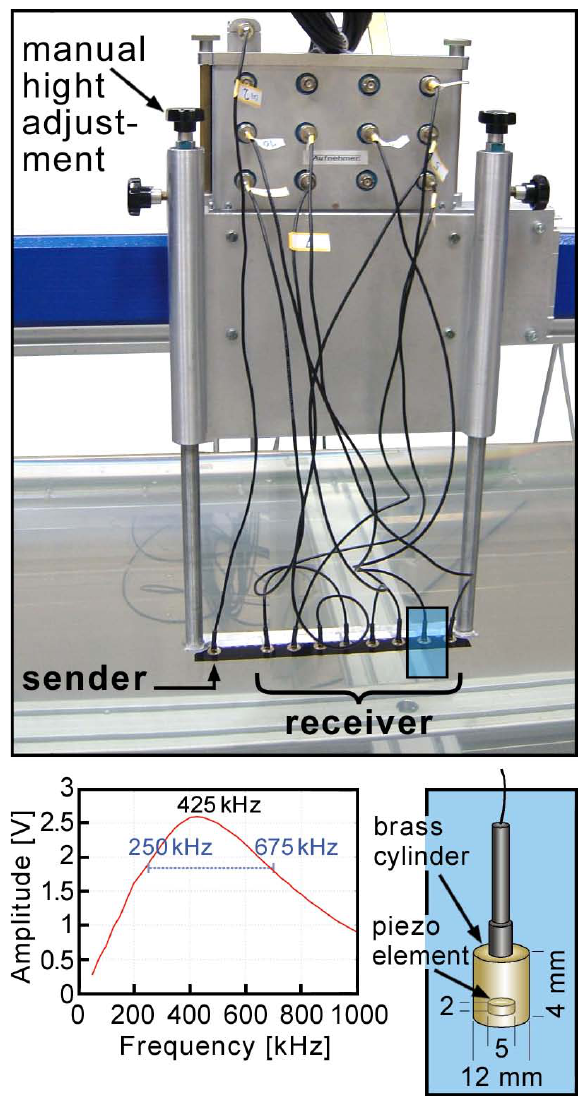
Fig. 3. Transducer array (top) and technical characteristics of the piezoelectric elements used